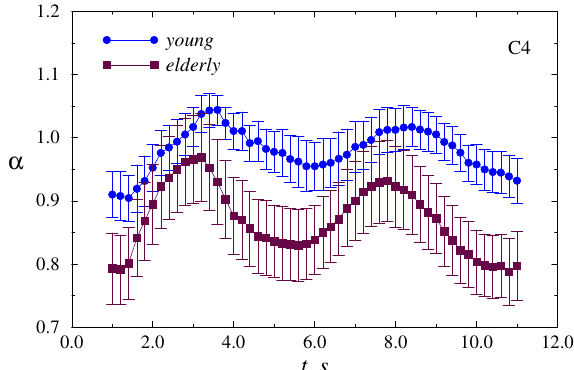
Figure 3. Average dependencies of α on the position of a 2-s (500 samples) floating window, which show the increase in scaling exponent caused by motor tasks. Two segments of increased α are related to clenching/unclenching the hand into a fist.